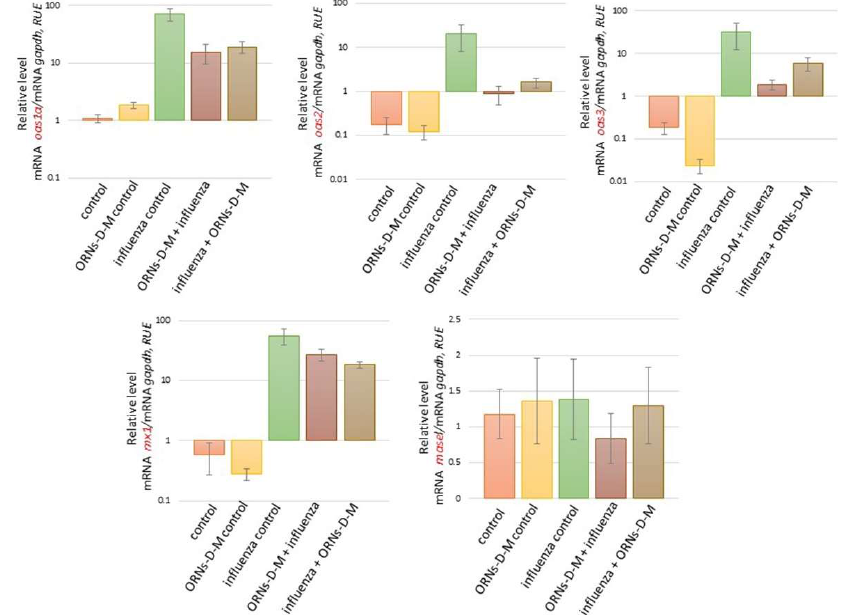
Figure 3. Impaired up-regulation of ISGs oas1a , oas2 , oas3 , mx1 , and rnasel induced by the influenza virus A/Fort Monmouth/1/1947-mouse adapted (H1N1) owing to the ORNs- D -М in vivo. Before and after infection with the influenza virus FM147 (4.0 lg LD 50 ), the BALB/c mice were treated with the ORNs- D -М. Total RNAs from the mice lungs were isolated and RT-qPCR was performed. The investigated mRNA levels were normalized to gapdh as a control. RUE: relative units of expression. ORNs- D -М control—ORNs- D -М injection into healthy mice, influenza control—infection of mice with an influenza virus, ORNs- D -М + influenza—ORNs- D -М injection 24 hours before influenza virus infection as prevention with ORNs- D -М, and influenza + ORNs- D -М—ORNs- D -М injection 24 hours after influenza virus infection as treatment with ORNs- D -М. Data are shown as the mean ± SD for three independent experiments.